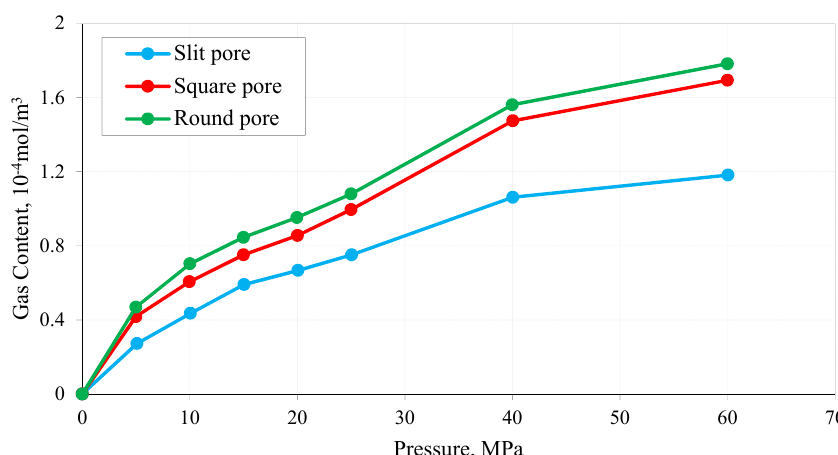
Figure 9. Methane adsorption per unit area.